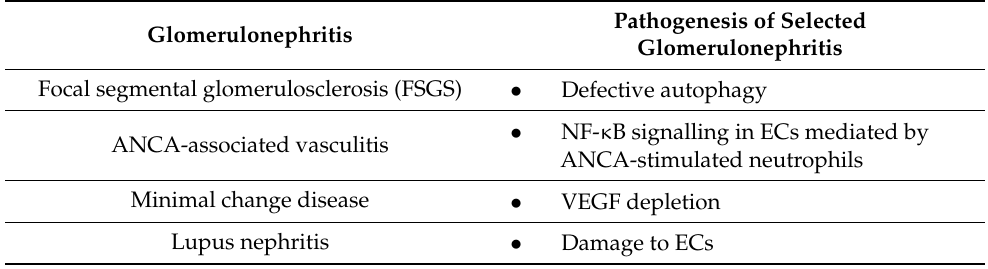
Table 2. Potential links between glomerulopathies and abnormal GR